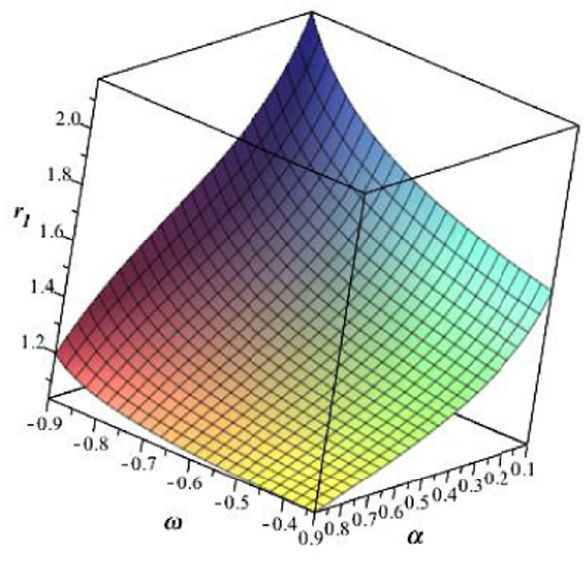
Fig. 5 The plot depicts the function r 1 ( n ,ω,α) as a function of ω and α for n = 3. It is clear that r α or ω increases. See the 1 decreases as text for